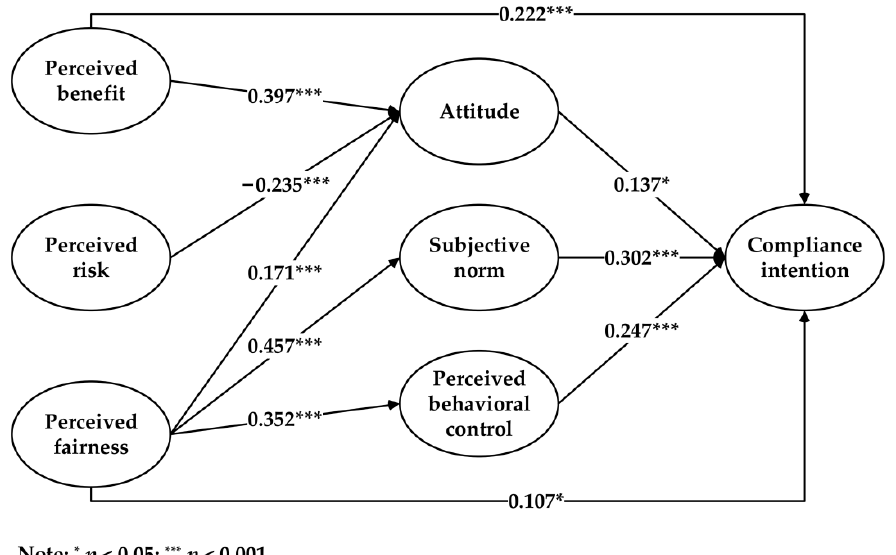
Figure 3. Path analysis results.